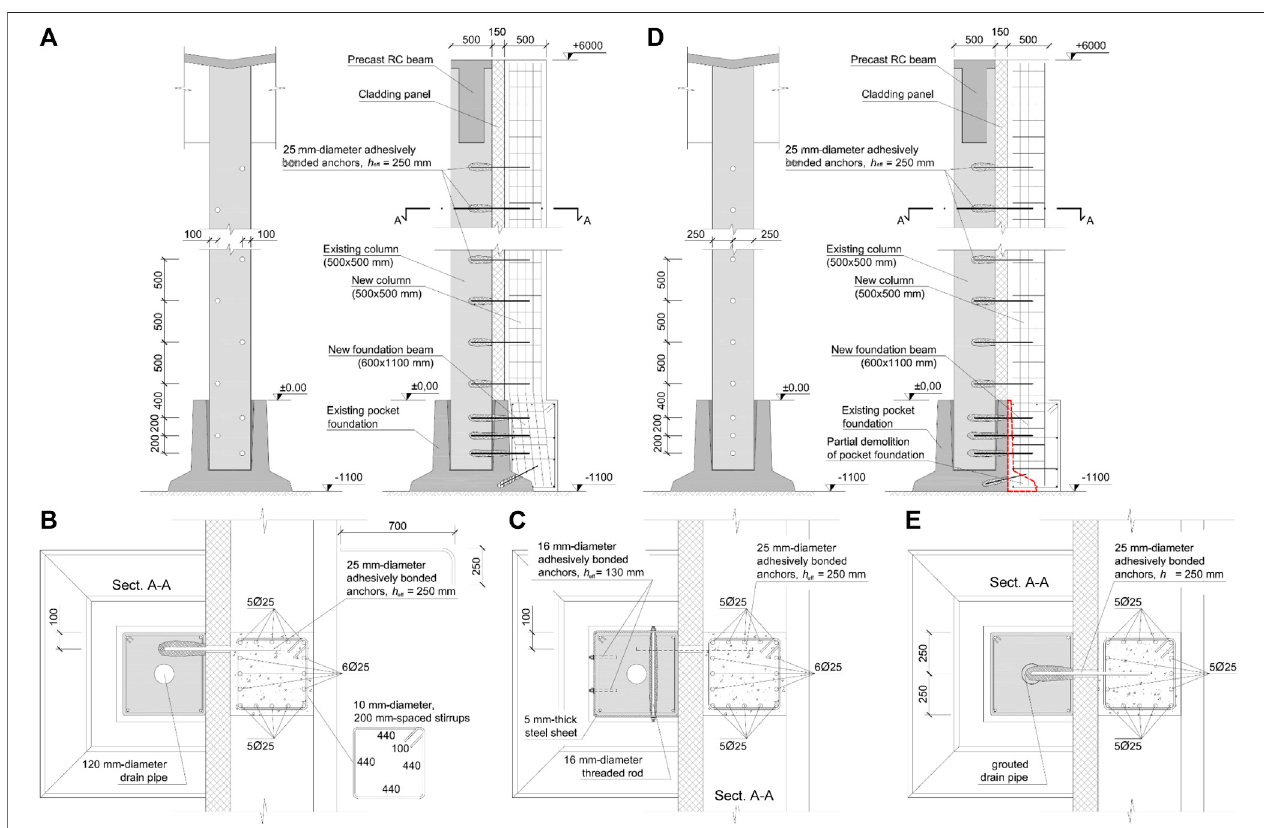
FIGURE 5 | Column doubling on the outside: (A) solution preserving the existing foundation with connectors near the column edges and (B) without or (C) with protective metal sheet; (D) solution involving partial demolition of existing foundation and (E) connectors far from edges. Dimensions in mm.